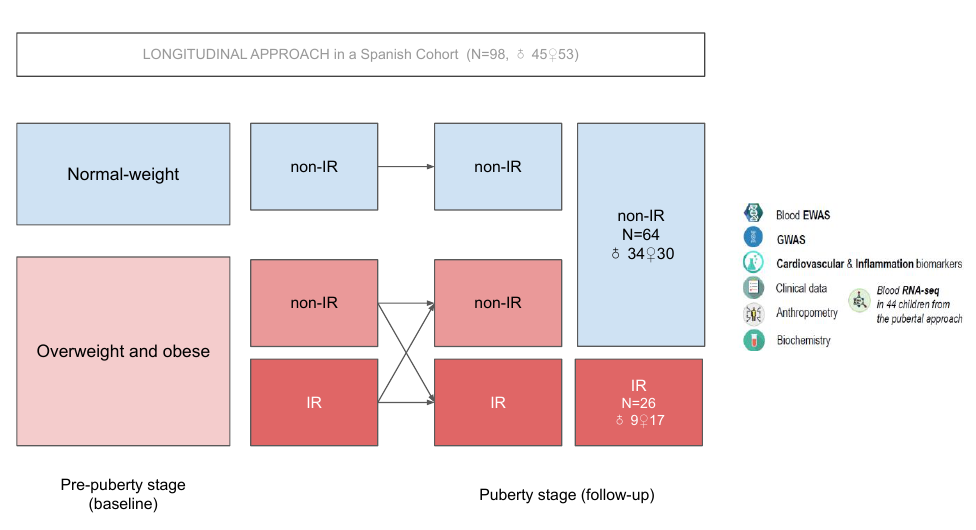
Figure 1. Summary of the PUBMEP